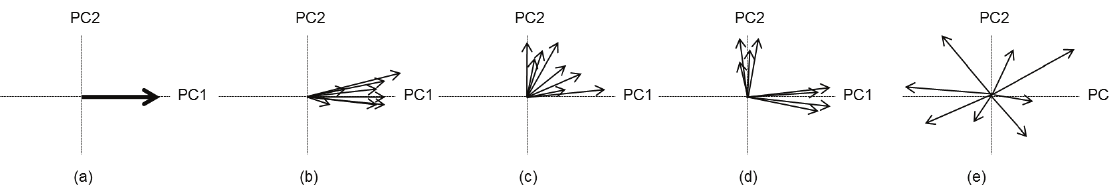
Fig. 3. Illustration of possible configurations for the PCA diagram: each vector represents an evaluation criterion (analysis is done per model structure). The axes are formed by the first two principal components (PCs). (a) represents a fully consistent model structure, (e) a fully inconsistent model structure.